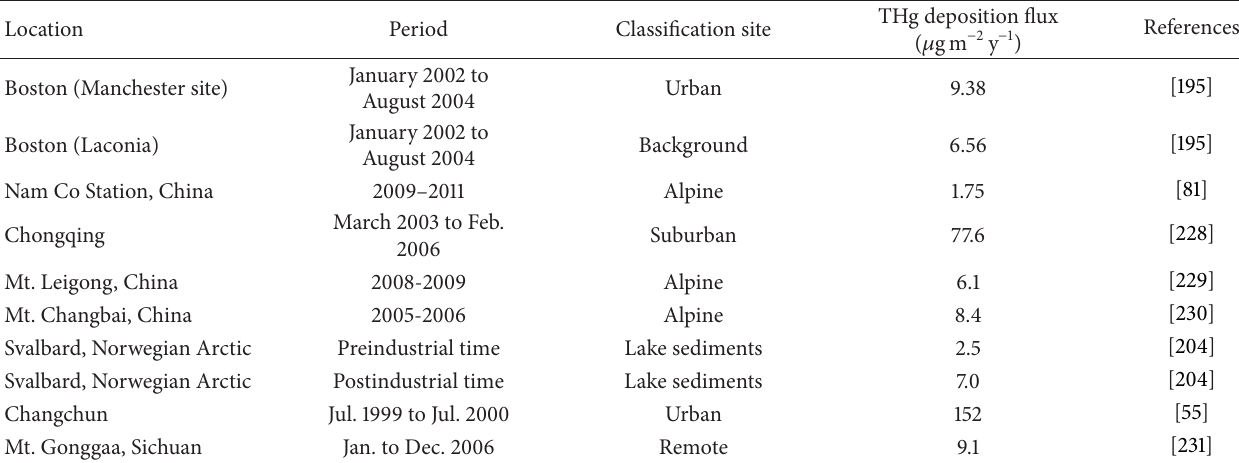
Table 11: Collection of some data of THg deposition fluxes.